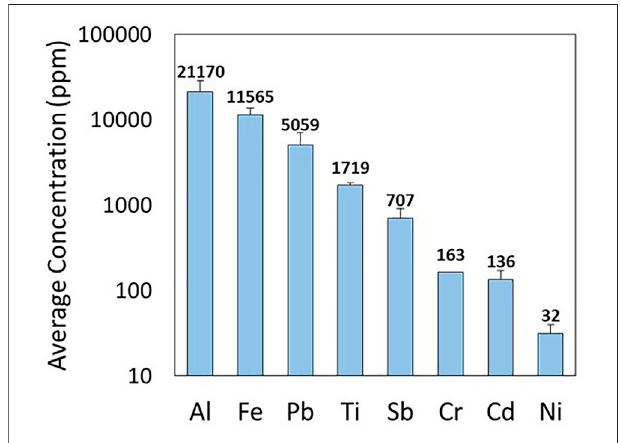
FIGURE 5 | Concentrations of heavy metals in fl y